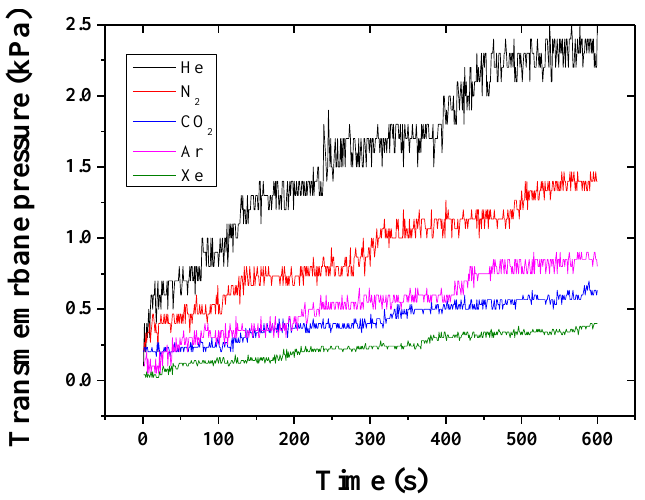
Figure A2. Representative permeation for short times across ZiF-8@BP membranes for the series of gases tested (He, N2, CO 2 , Ar, and Xe).